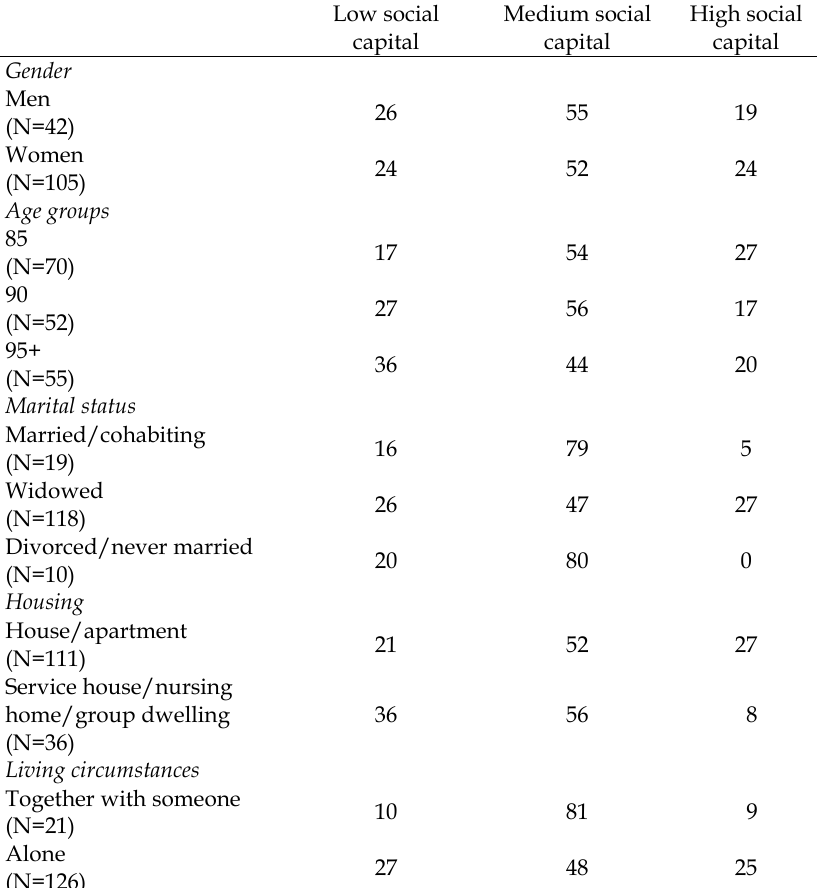
Table 4. Distribution (%) of social capital by gender, age group, marital status, housing and living